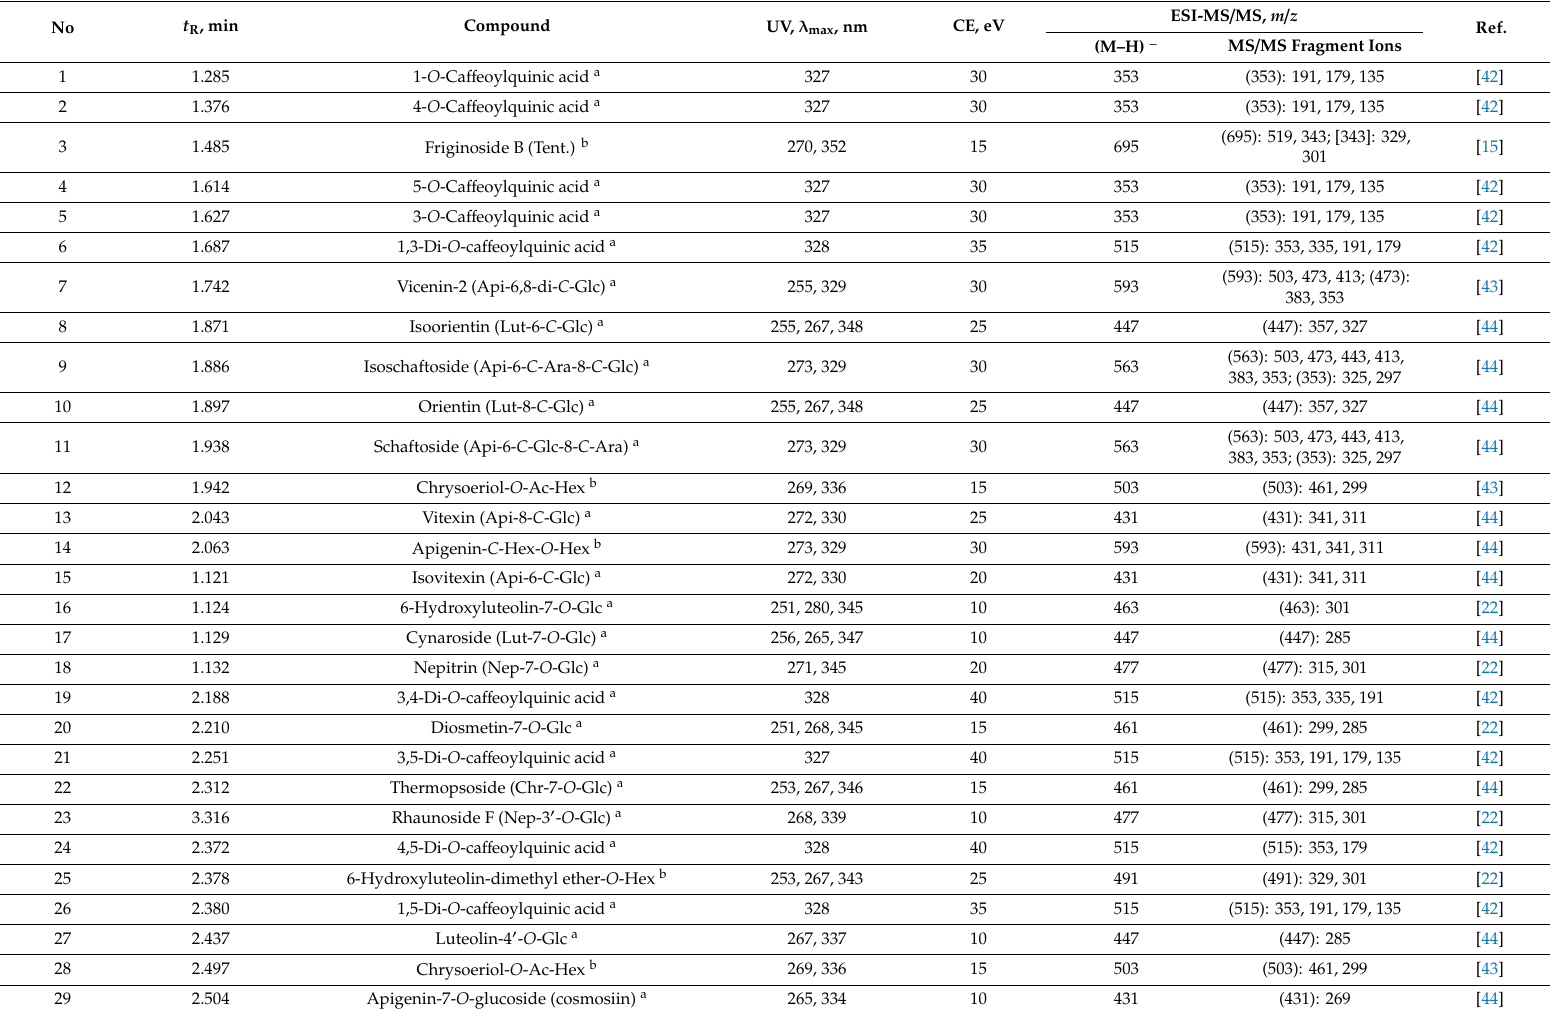
Table 2. Chromatographic ( t R ), ultraviolet data (UV), collision energy (CE) and mass-spectrometric data (ESI-MS / MS) of compounds 1–59 found in A. frigida